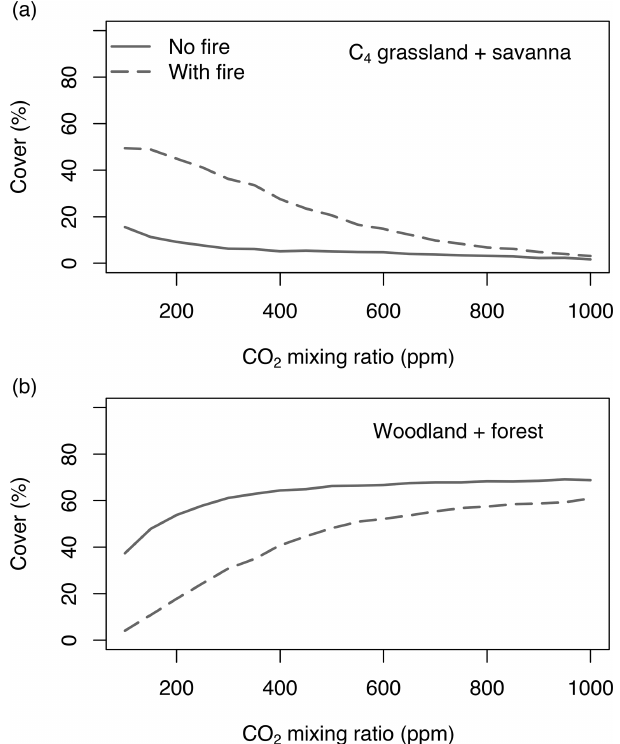
Figure 1. Area of Africa covered by (a) C 4 -dominated (C 4 grass- land and savanna) and (b) C 3 -dominated (woodland and forest) veg- etation under equilibrium conditions. Simulations were conducted until vegetation reached an equilibrium state under fixed CO 2 . Dif- ferences between simulations without fire (solid lines) and with fire (dashed lines) indicate that both C 3 - and C 4 -dominated vegetation states are possible. Figure S1 shows cover fractions separated by biome